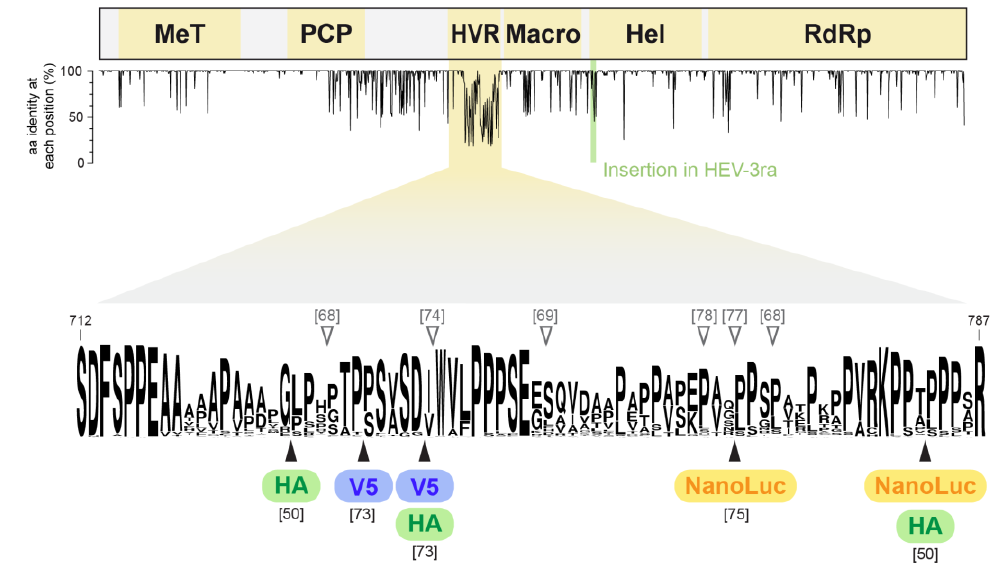
Figure 2. Engineered epitope tag and reporter insertions in HEV ORF1 genomic region. The sequence alignment of 155 HEV-3 ORF1 amino acid (aa) sequences, found in the databases, with exclusion of HEV-3ra and sequences harboring insertions in the HVR, served as basis for the aa identity sequence profile. Results of this alignment in the HVR, aa 712 – 787, is provided as an aa logo generated with the WebLogo application [76]. Some of the reported positions where natural insertions occurred, of which some served as reference for the targeted tagging approaches, are indicated by empty arrowheads with the corresponding citations [68,69,74,77,78]. Positions where epitope tags, HA or V5, as well as NanoLuc reporter have been successfully inserted in HEV-3 molecular clones, i.e., 83-2, p6 or pJE03-1760F, are indicated with their reference [50,73,75].